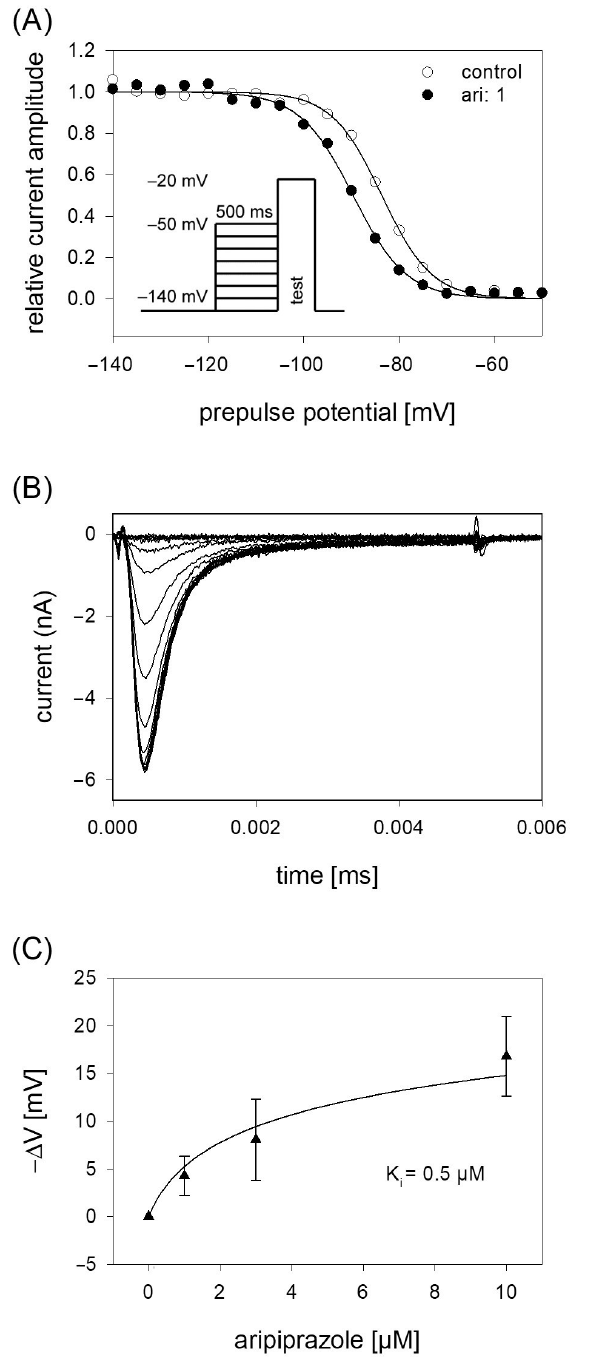
Figure 4. Voltage dependence of fast inactivation. ( A ) Data of normalized peak currents are plotted against the prepulse potential. Solid lines represent fits according to Equation (4). Insert: Experimental scheme. Voltage dependence of fast-inactivation was determined by measuring sodium currents elicited by 5 ms depolarizations to − 20 mV after conditioning prepulses for 500 ms to different potentials (range − 140 to − 50 mV) in the absence (open circles) and presence ( fi lled circles) of 1 μ M aripiprazole. Holding potential was − 140 mV. ( B ) Overlay of original current traces obtained for control. ( C ) Relative shift of inactivation midpoints in relation to the applied concentration of aripiprazole. Data are corrected for the drug ‐ independent shift (1.0 mV/measuring cycle) and fitted according to Equation (6) using the mean slope obtained in the presence of aripiprazole. The fit gives an affinity of 0.5 ± 0.14 μ M for the fast ‐ inactivated state.